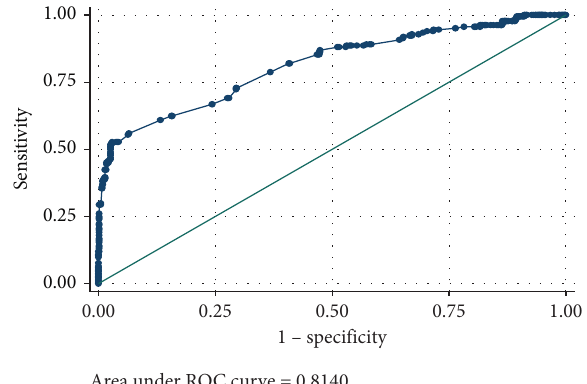
Figure 2: Receiver operator characteristic curve analysis and es- timation of the